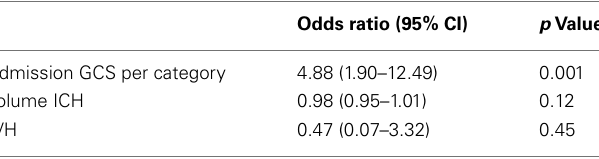
Table 3 | Multivariable analysis: association of prognostic factors with awakening from